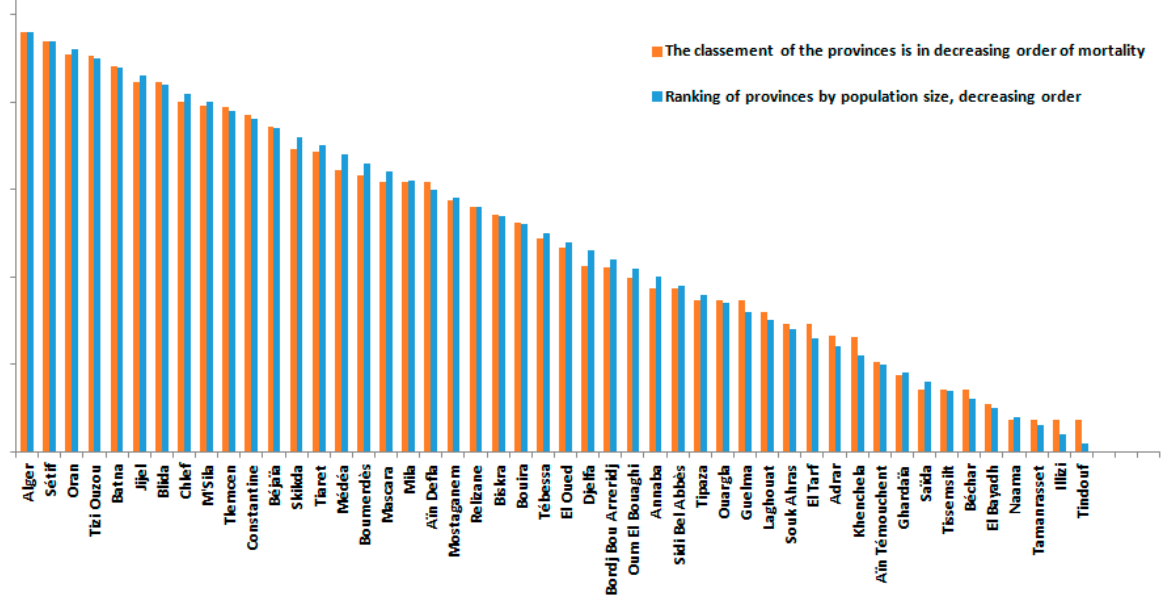
Figure 6. Classification of mortality rates in Algerian provinces (48 provinces) by COVID-19